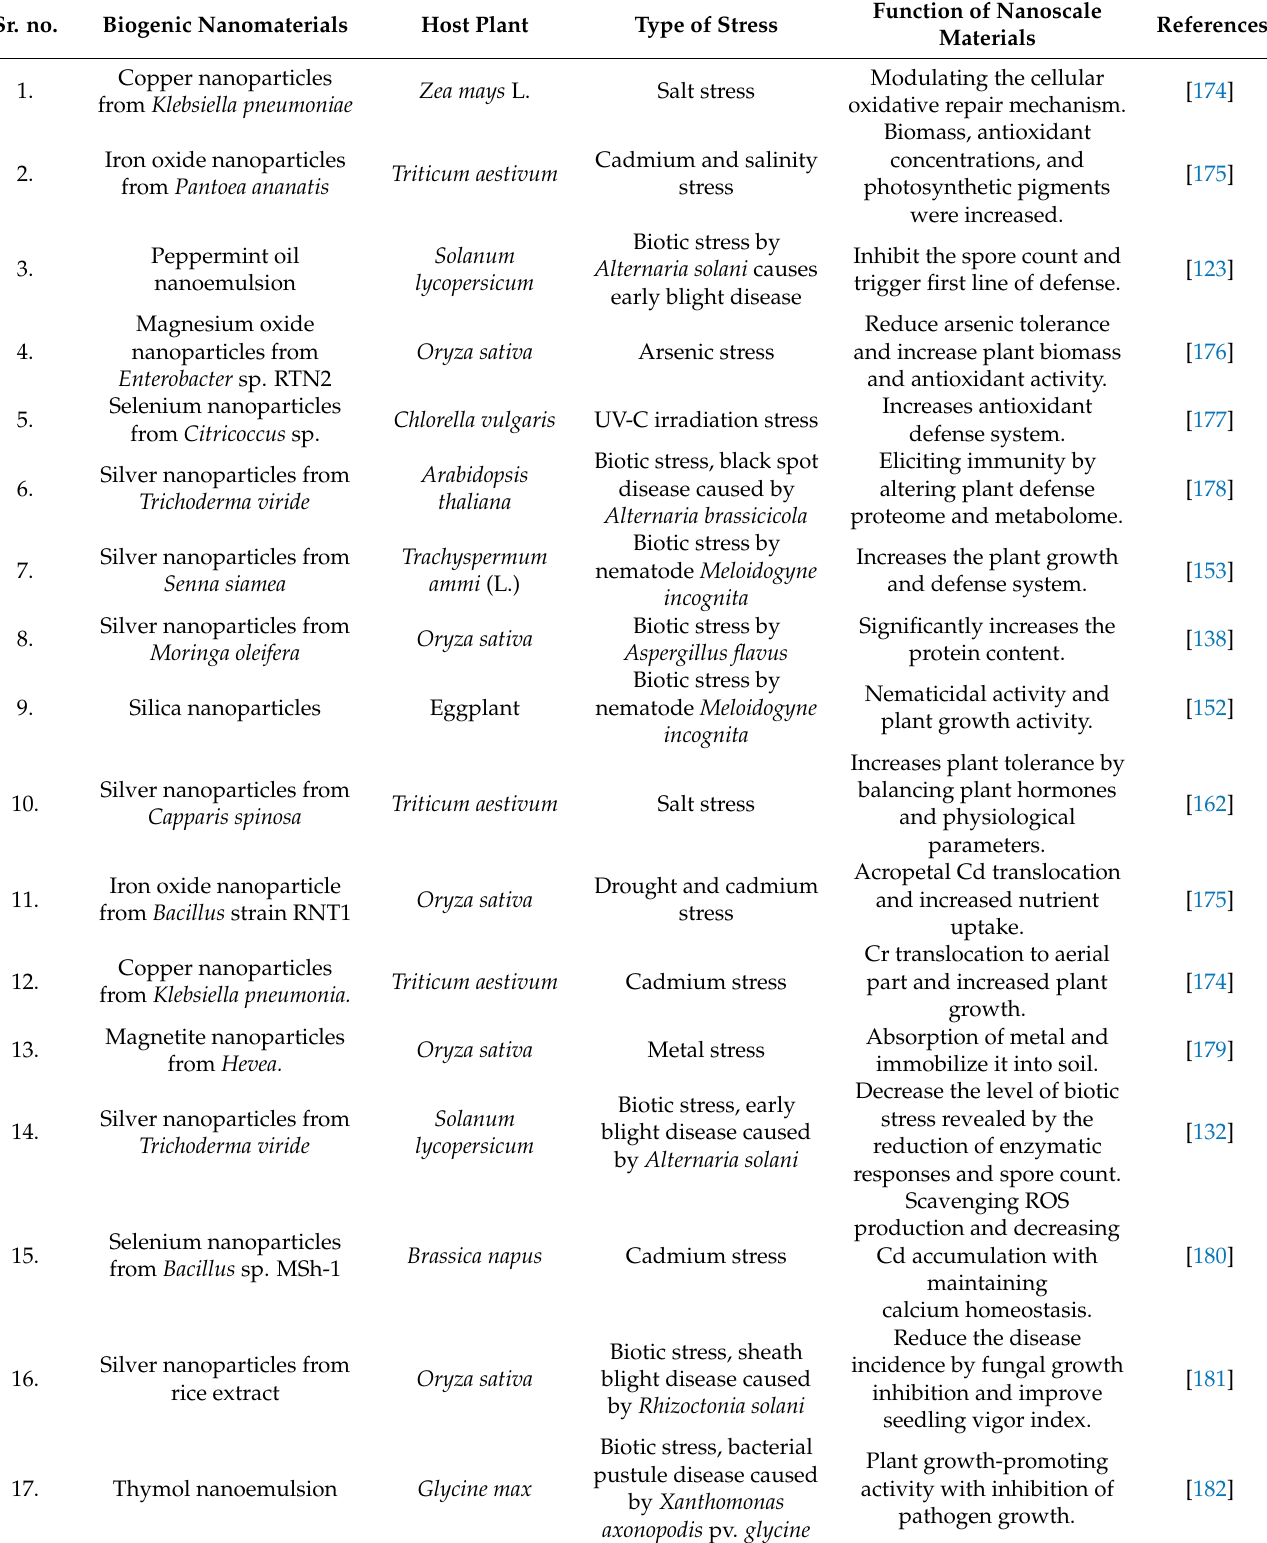
Table 1. Biogenic nanoscale agro-materials used to enhance the stress tolerance and protective management of plant